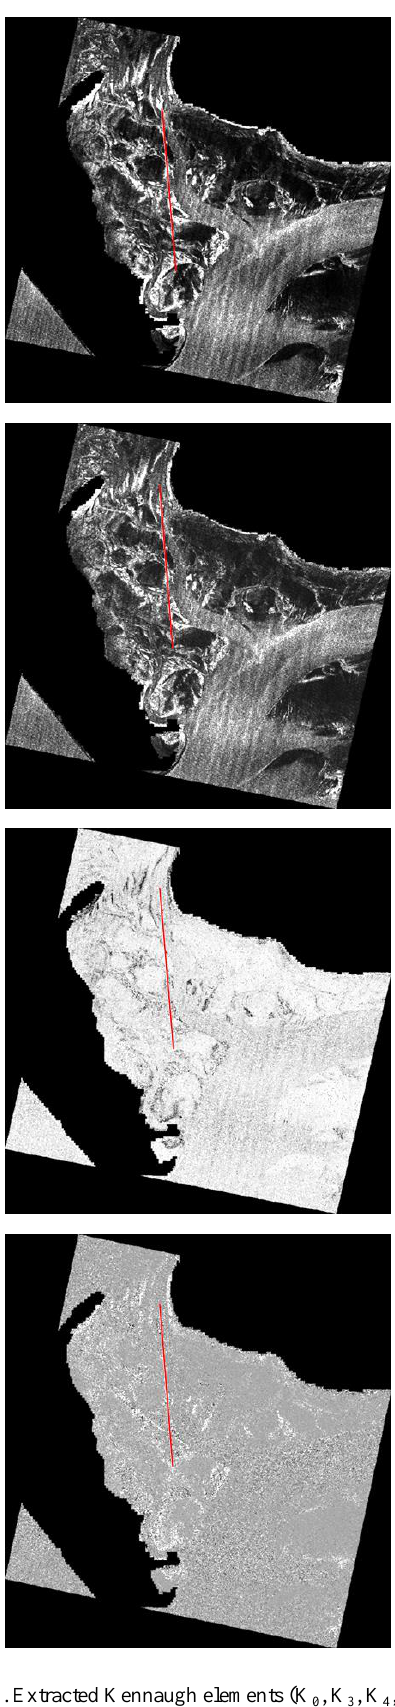
Figure 3. Extracted Kennaugh elements (K 0 , K 3 , K 4 , and K 7 ) from the TerraSAR-X scene of Jun. 20. The red line is the used transect line in Figure